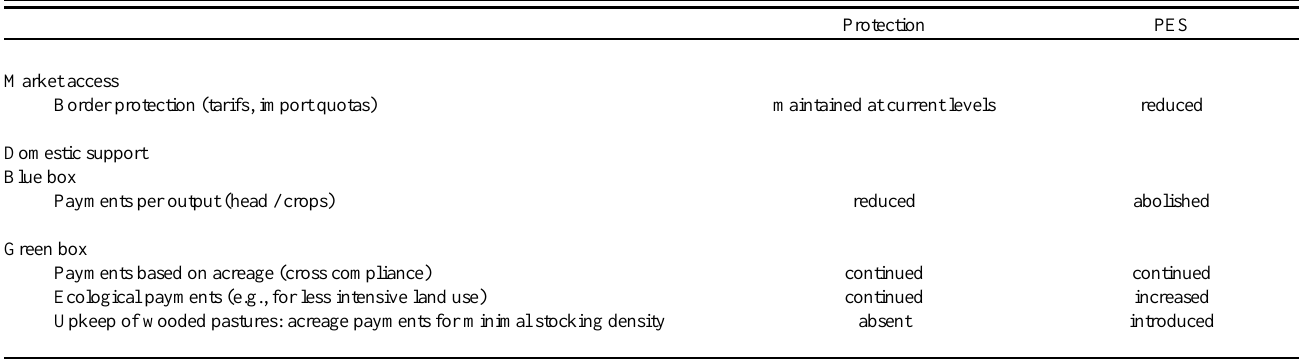
Table 1 . Instruments in the two considered policy scenarios: “Protection” and “Payment for environmental services